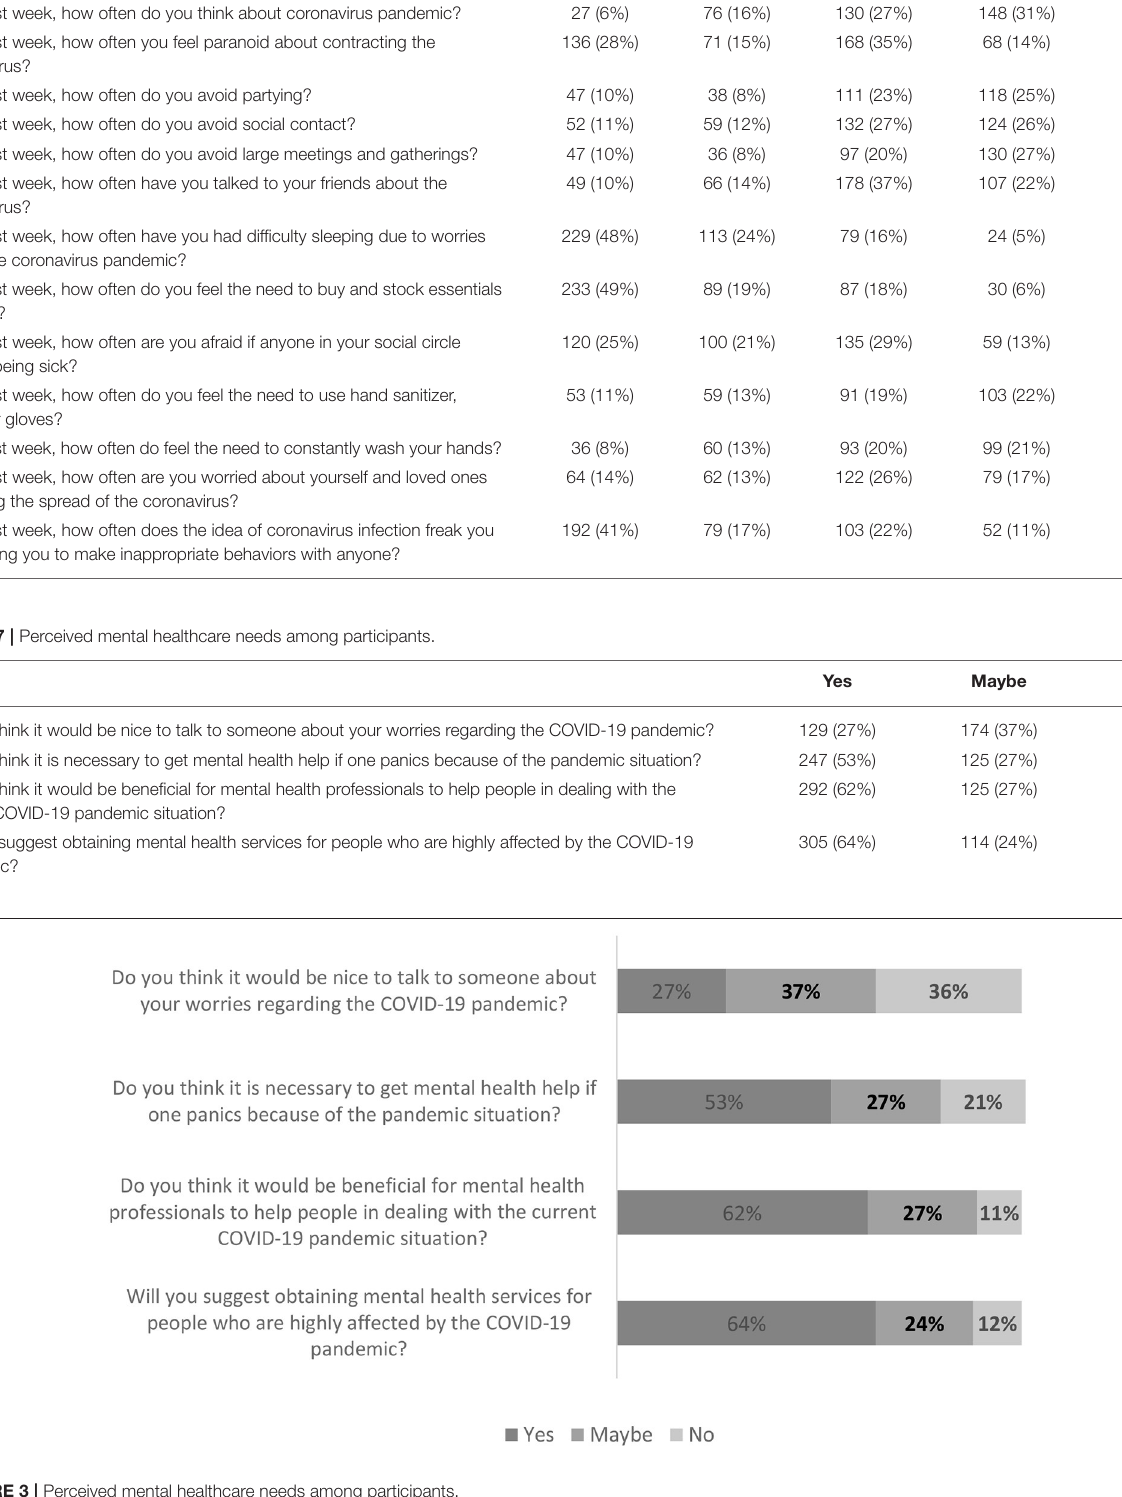
Never Unlikely Maybe Most likely Definitely